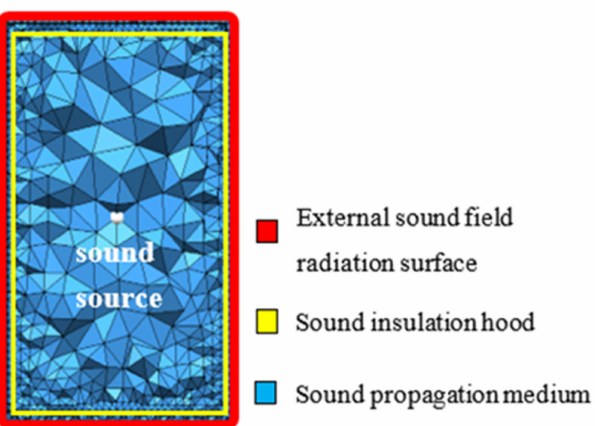
Figure 2. Schematic diagram of numerical simulation grid.